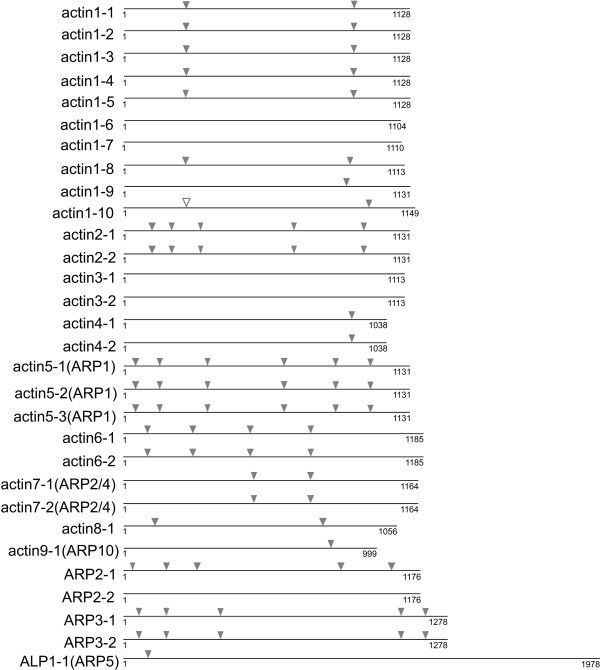
Position of introns in the nucleotide sequence of actins and actin-related proteins in P. tetraurelia. The position of the introns (gray arrowhead) are as follows (bp): subfamily 1, intron I (241–270), intron II (907–933); subfamily 2, intron I (110–140), intron II (218–243), intron III (332–354), intron IV (731–754), intron V (976–1001); subfamily 4, intron I (900–925); subfamily 5, intron I (45–74), intron II (139–163), intron III (359–381), intron IV (690–716), intron V (922–948), intron VI (1108–1132); subfamily 6, intron I (93–120), intron II (273–303), intron III (530–528), intron IV (799–825); subfamily 7, intron I (514–539), intron II (738–766); subfamily 8, intron I (121–141), intron II (780–804); subfamily 9, intron I (818–845); subfamily ARP2, intron I (35–57), intron II (169–189), intron III (321–350), intron IV (920–949), intron V (1129–1161); subfamily ARP3, intron I (58–82), intron II (168–191), intron III (410–435), intron IV (1170–1196), intron V (1280–1305); subfamily ALP1, intron I (84–109). White arrowhead marks non-spliced intron (see text).